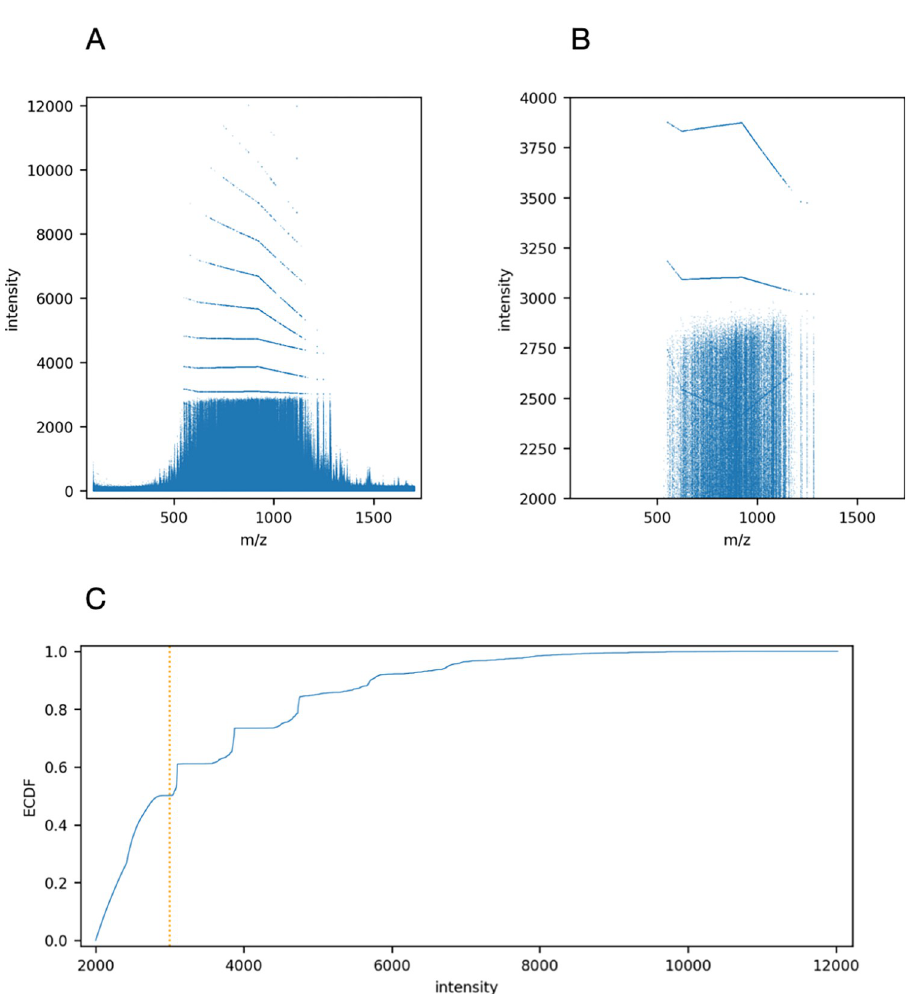
Fig 6. Effects of saturation on indicated intensity across the m/z range. (A) Raw data from analysis of the Yeast- HeLa-E.coli mixture, showing the nonlinearities in the readings where the detector is saturated. (B) Enlargement of the raw data intensity range. (C) The empirical cumulative distribution of the raw points, showing that more than half the raw points are affected by